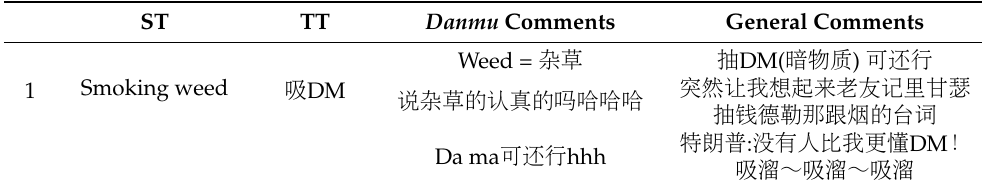
Table 3. An instance of corpus and